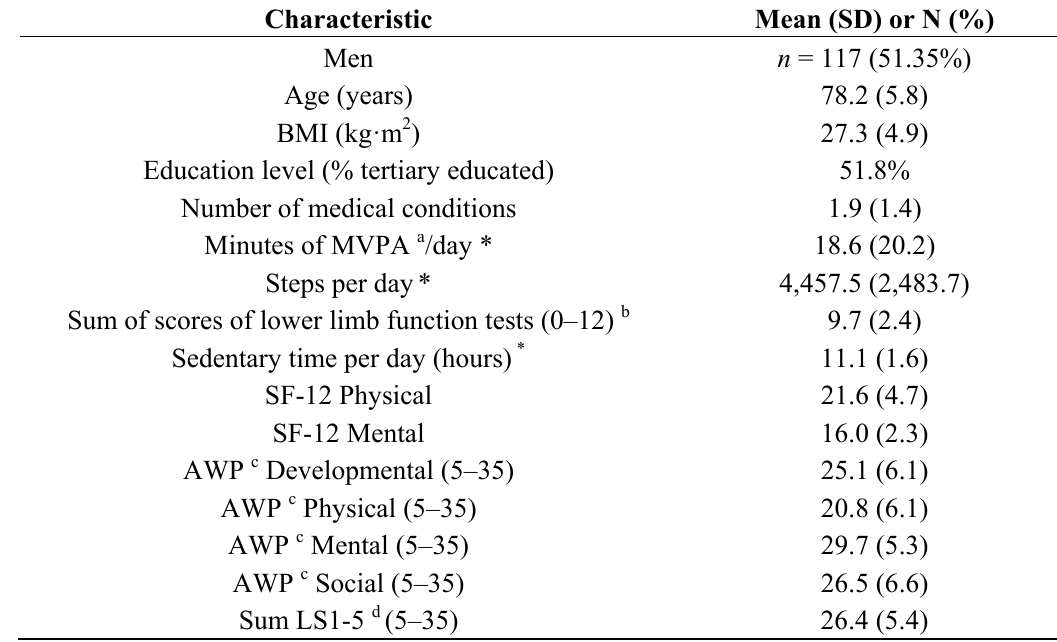
Table 1. Demographic, MVPA, steps, lower limb function, sedentary time and well-being characteristics of study participants ( n =